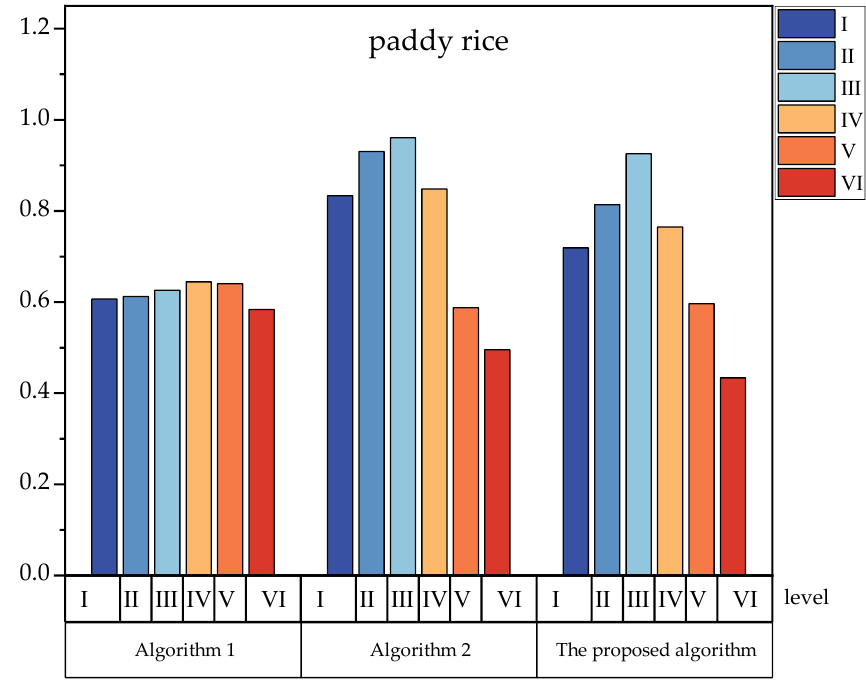
Figure 3. Histograms of the membership degrees of polished rice.